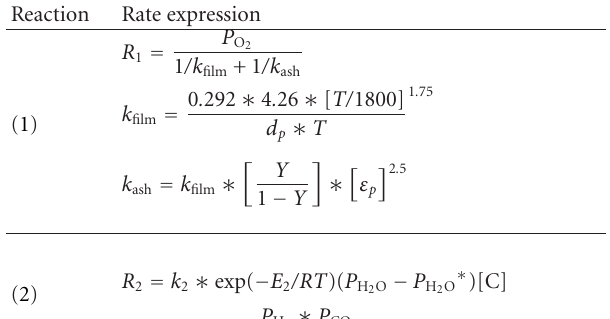
Figure 2: E ff ect of steam to coal ratio on product gas composition.